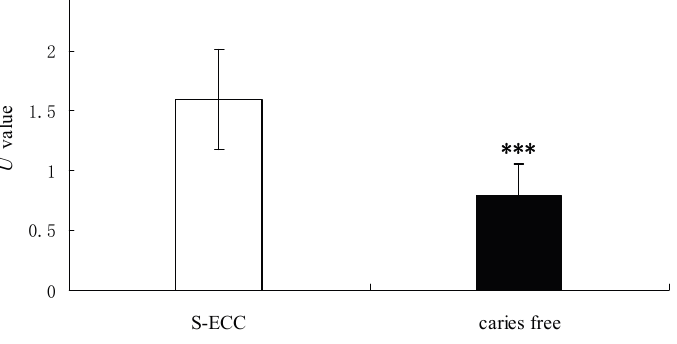
/OD ), which represent 280 490